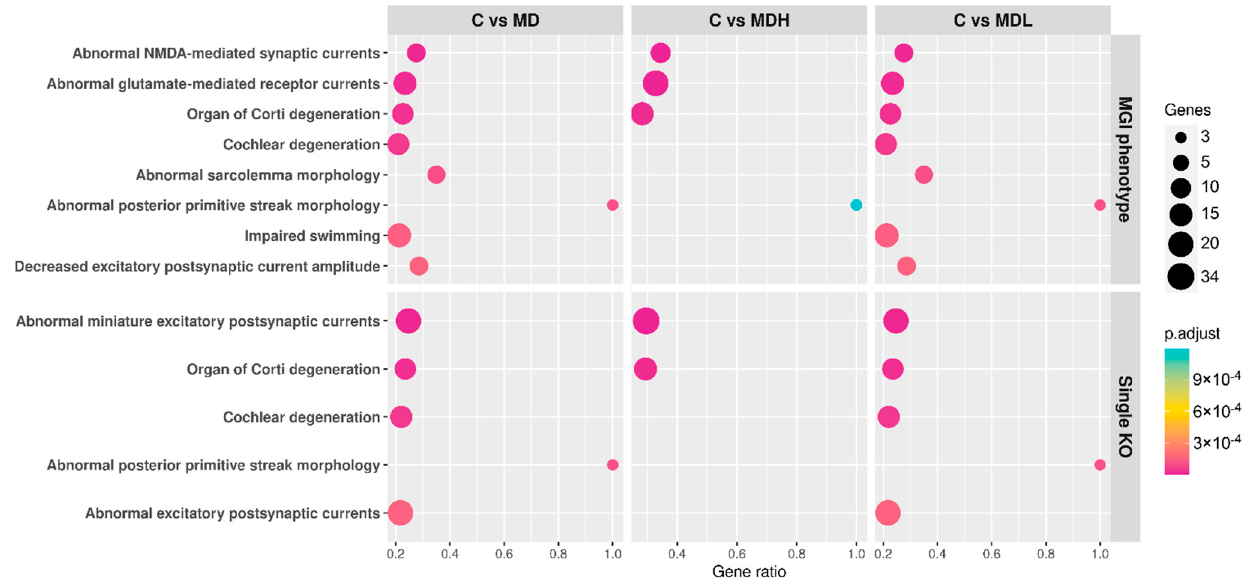
Figure 5. Mouse phenotype associated with differentially methylated CpGs and regions. Dot-plot representing the gene ratio and adjusted p -value associated to each mouse phenotype, retrieved from comparing Meniere disease patients to controls, Meniere disease patients with high cytokines to controls, and Meniere disease patients with low cytokines to controls in GREAT web tool.